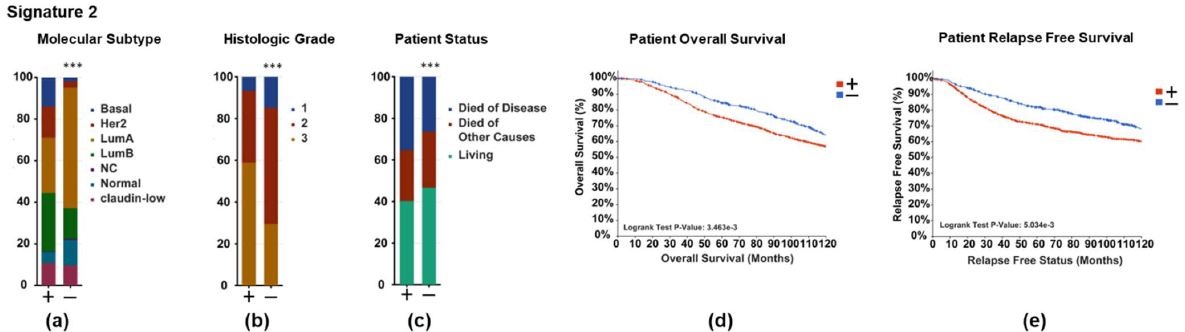
Figure 6. Invasive Signature 2 is associated with poor outcome in ER+ breast cancer patients. cBioPortal for Cancer Genomics was used to query 1904 patients with breast tumors from the METABRIC cohort for genes downregulated by ICI in Signature 2. Patients were stratified on the basis of high expression (+ = mRNA expression 3 standard deviations above the mean) or low expression (− = mRNA expression below 3 standard deviations below the mean) of genes downregulated by ICI from Signature 2, normalized to the reference population, where each gene is compared to the mean level of expression of all samples in the cohort. The distributions of the ( a ) molecular subtype, ( b ) histologic grade, ( c ) patient status, ( d ) patient overall survival, ( e ) and relapse-free survival between (+) and ( − ) groups are displayed. Statistical significance was determined